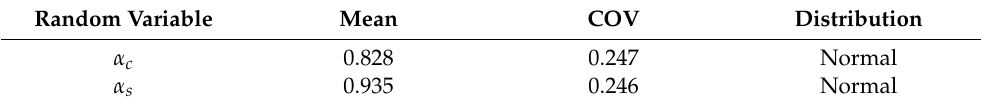
Table 5. Statistical characteristics of the posterior distribution of the parameters of the PC beam.